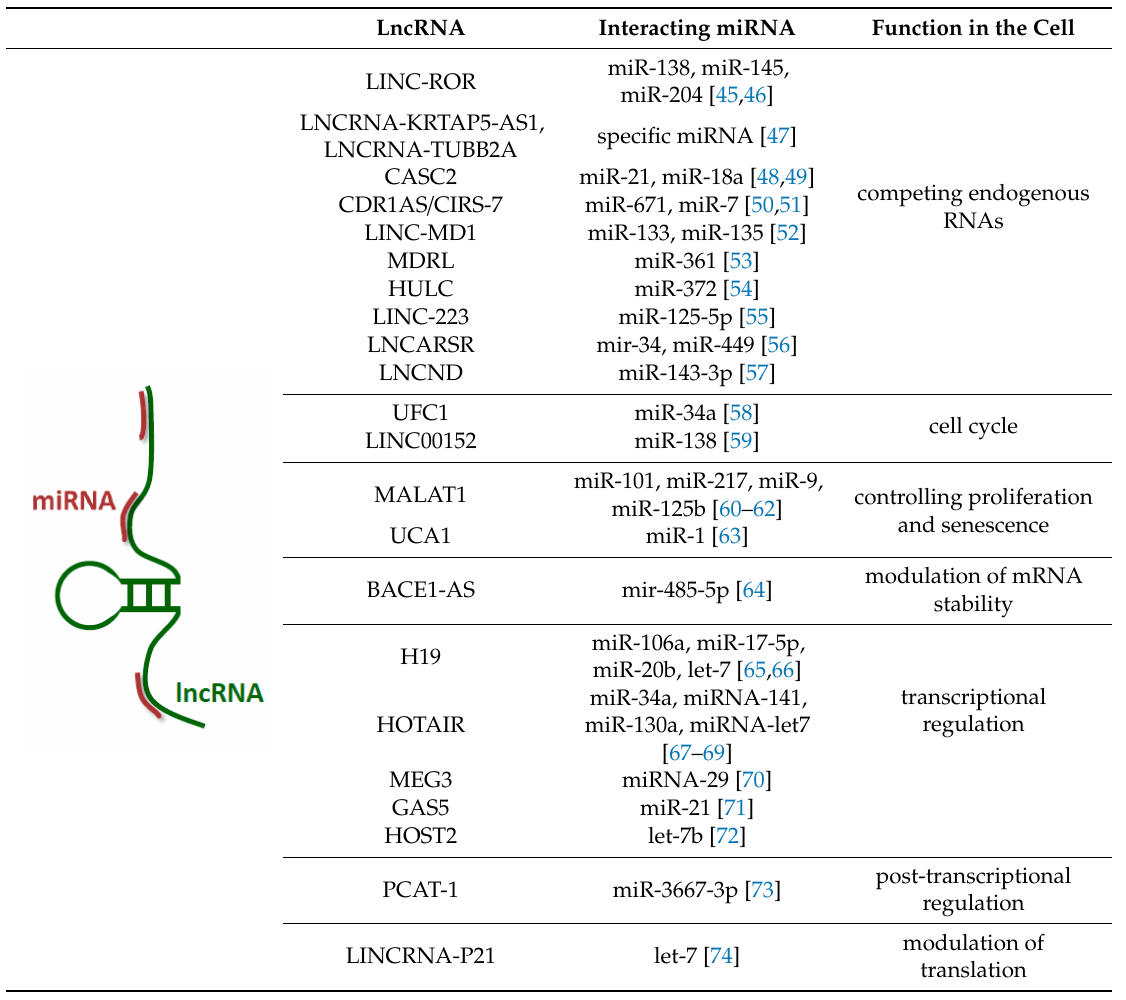
Table 2. Selected lncRNAs interacting with microRNA (miRNA) and their